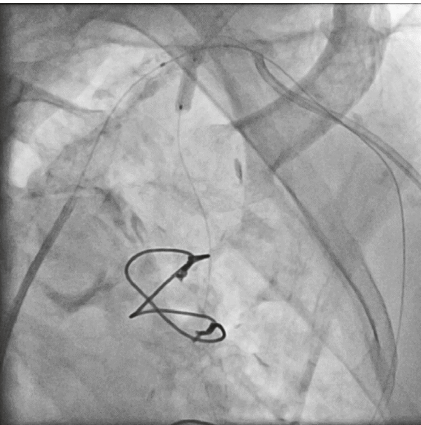
Figure 4: The DES is deployed in the LIMA with a balloon placed in the SA. The balloon will be inflated following stent deployment prior to concluding with final kissing angioplasty. DES, drug- eluting stent; LIMA, left internal mammary artery; SA, subclavian artery.